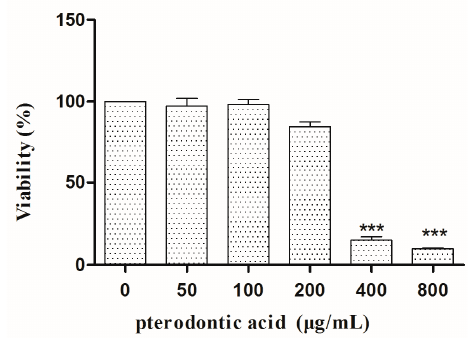
Figure 2. Cytotoxic effect of pterodontic acid on MDCK cells. For pterodontic acid cytotoxicity assays, MDCK cells were incubated with different concentrations of the compound. After 48 h, cell viability was measured by MTT assay. Values represent the mean (%) ± SD from three independent experiments. An ANOVA with Tamhane’s post-hoc analysis was applied, *** p < 0.001, relative to the values of untreated cells.